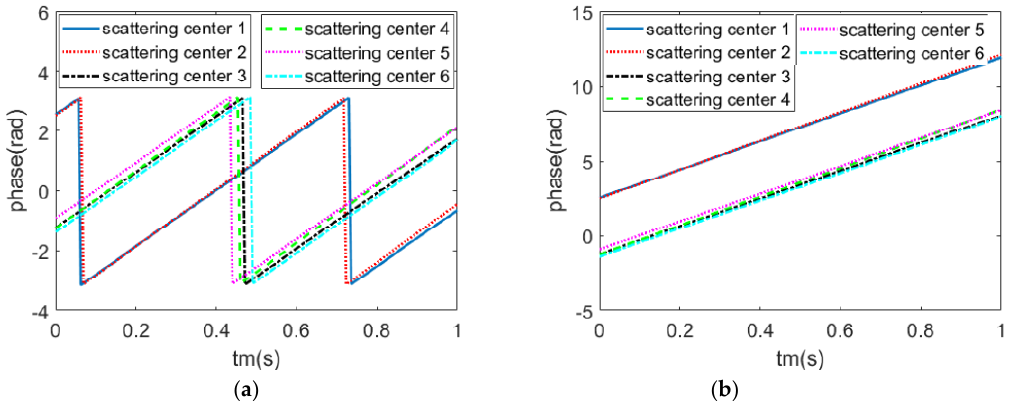
Figure 13. Phase difference curves of the spatial spectrum. ( a ) Before phase unwrapping. ( b ) After phase unwrapping.